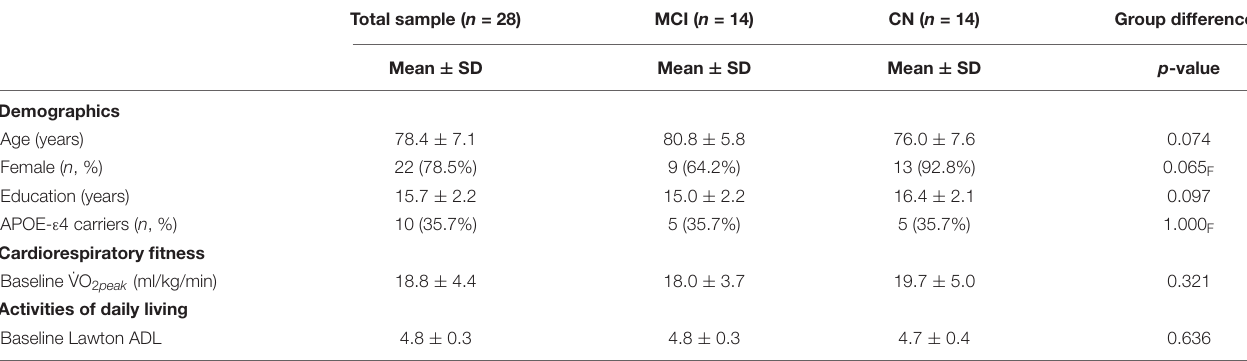
TABLE 1 | Demographic information for study